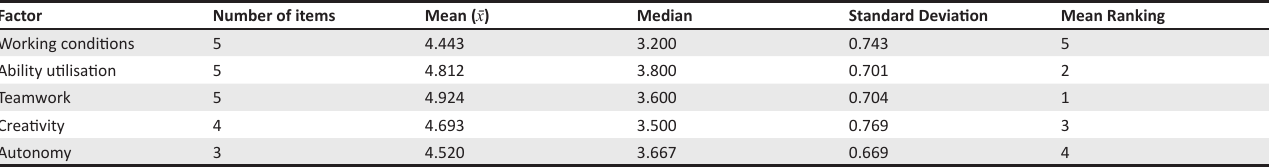
TABLE 5: Factor, number of respondents, mean, median and standard deviation for the employee satisfaction